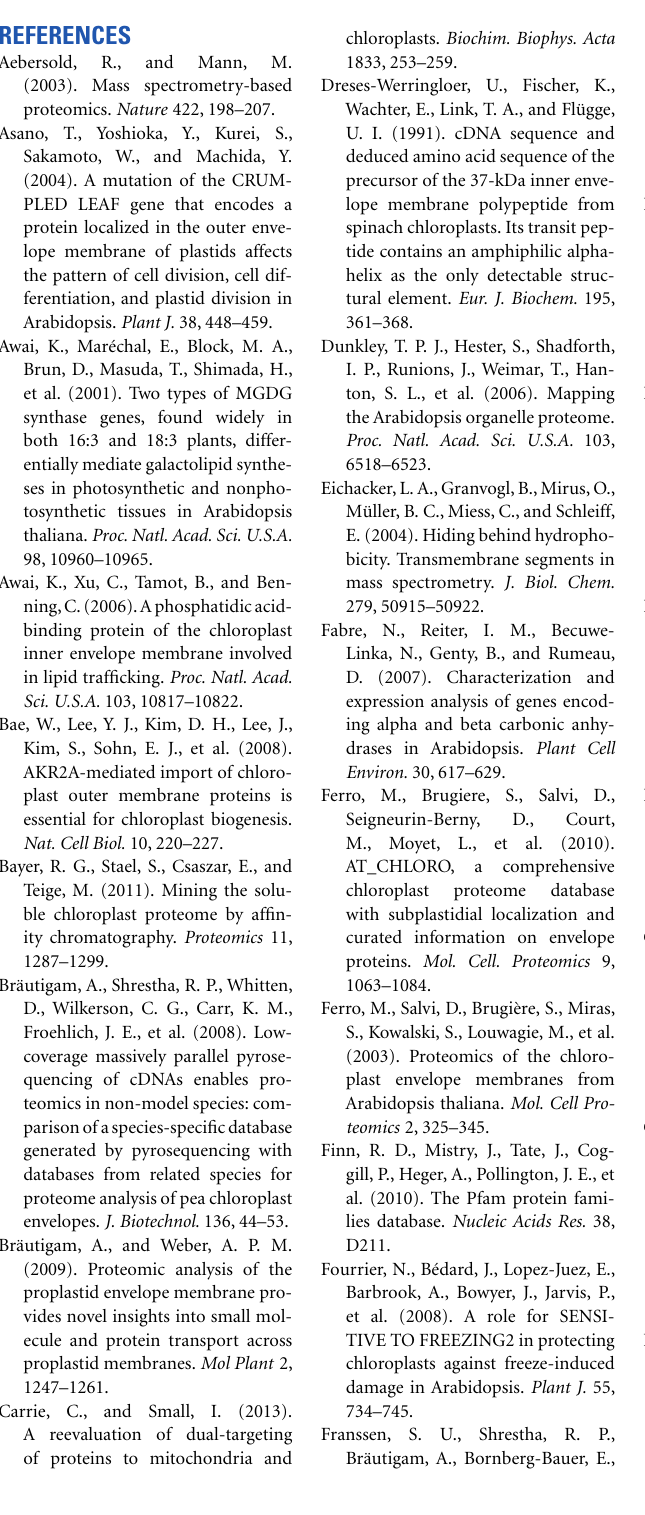
threshold, the 15th column the charge, the 16th column the mass to charge ratio in daltons ( m / z ), the 18th column the delta mass ( ∆ M, difference between the theoretical mass of the peptide and the experimental mass of the precursor ion), the 19th column the matched ions, and the 20th column the spectrum